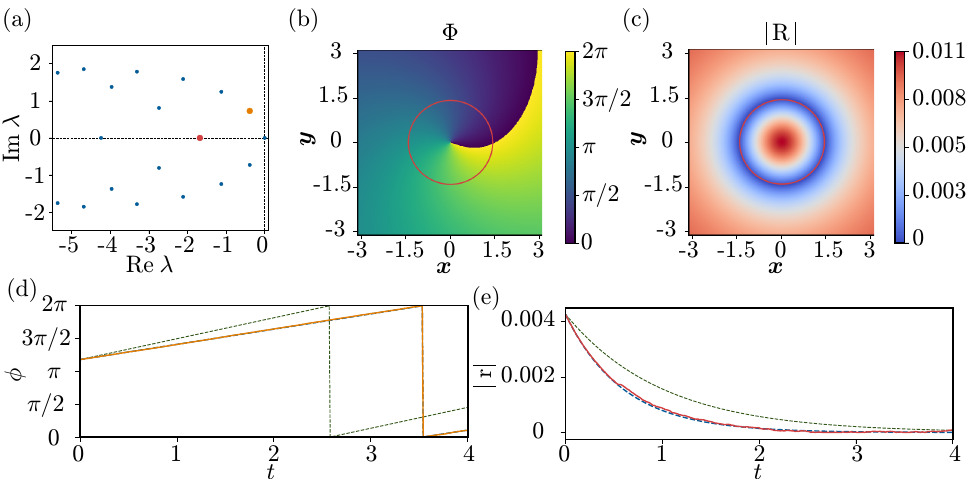
Figure 1. Phase and amplitude functions of a noisy Stuart–Landau model. ( a ) Eigenvalues of L + the imaginary axis. Orange and red dots represent Λ 1 and Λ 2 , respectively. ( b ) Phase function Φ ( x , y ) . The phase origin is chosen as ( x , p ) = ( 1.5,0 ) . ( c ) Amplitude function | R ( x , y ) | . ( d ) Evolution of averaged phase φ . ( e ) Evolution of averaged amplitude | r | . In ( b , c ), red-thin lines represent the deterministic limit-cycle solution. In ( d , e ), averaged results over 10,000 trajectories (orange and red thin lines) and analytical solutions (blue-dotted lines) for the stochastic case and results for the deterministic case (green-dotted lines) are